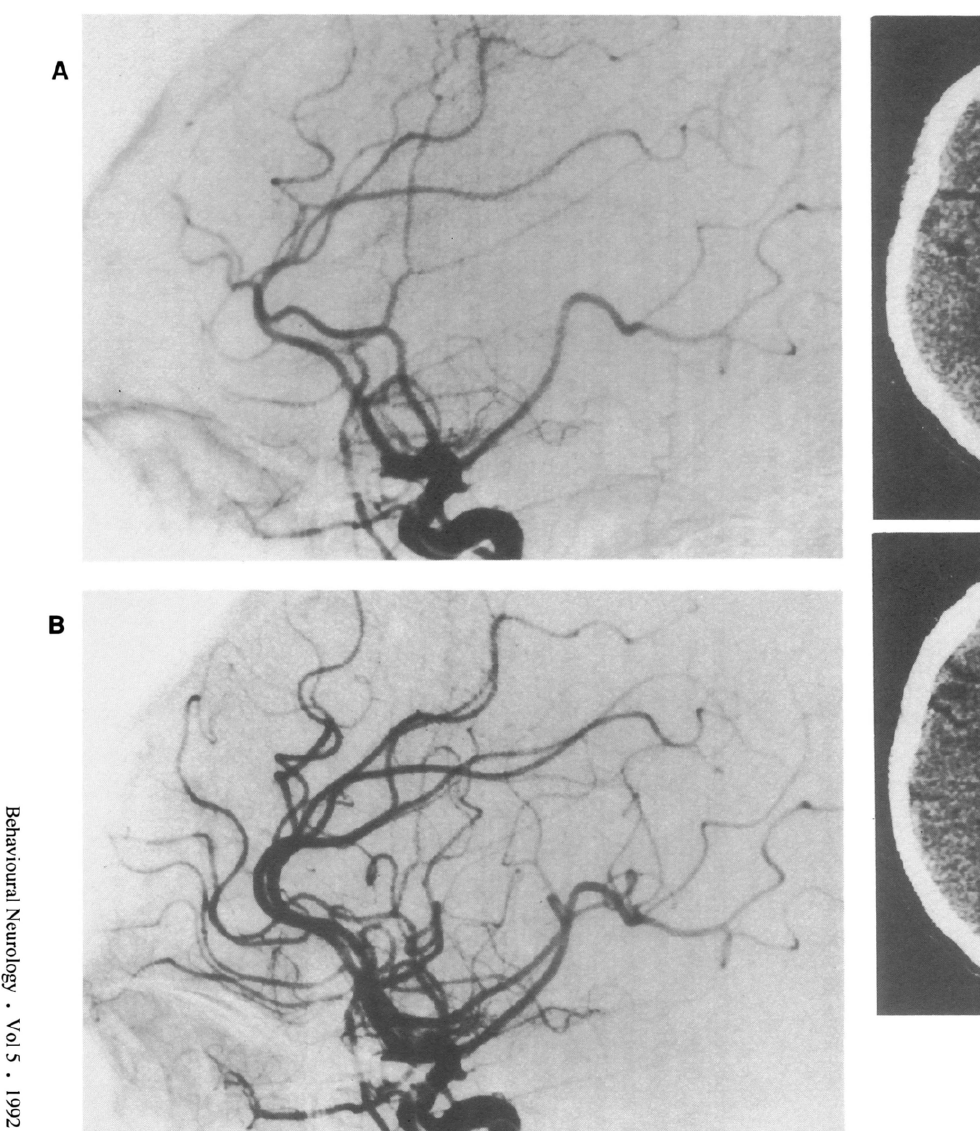
FIG. 2. CT scan. Hypodense areas are seen mainly in the subcortices of the left posterior frontal and anterior parietal regions. C.S., central